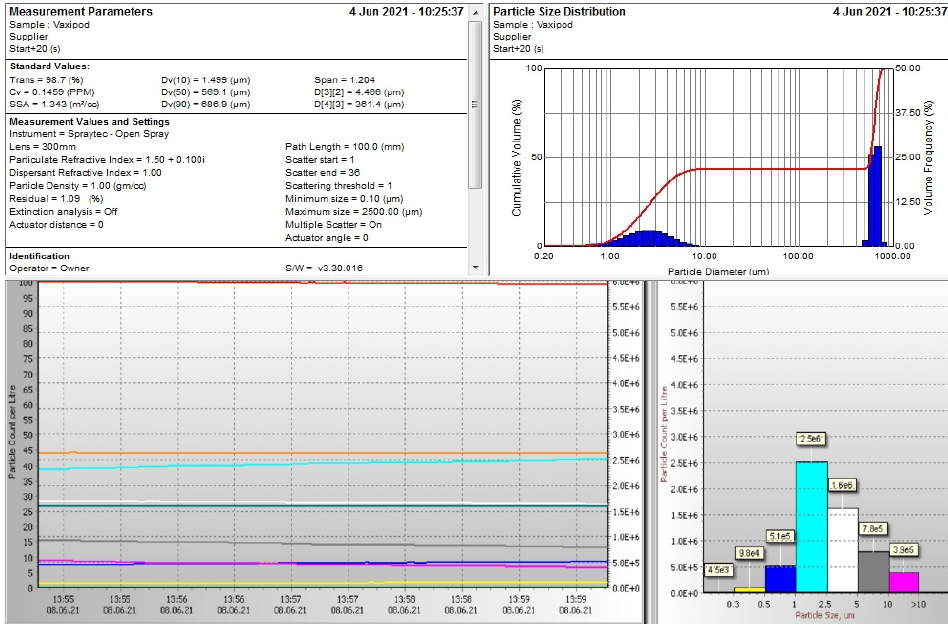
Figure 5. Size distribution of oils released by VaxiPod (Top figure was obtained by Sparytec, Malvern Panalytical, Malvern, UK; bottom figure was obtained by optical aerosol spectrometer, Model 4705, Aeronanotech, Moscow, Russia).